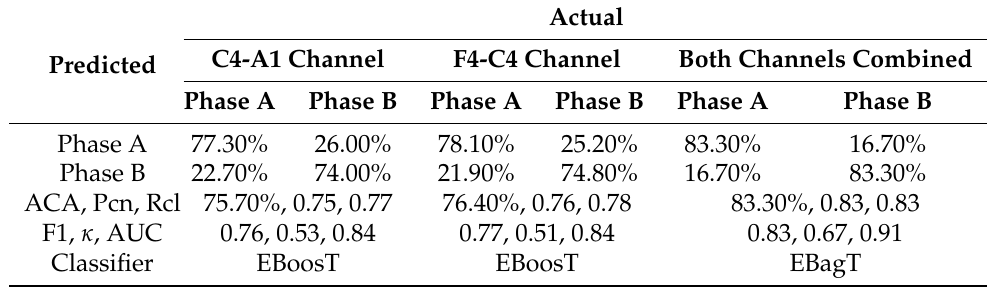
Table 4. Classification performance for healthy